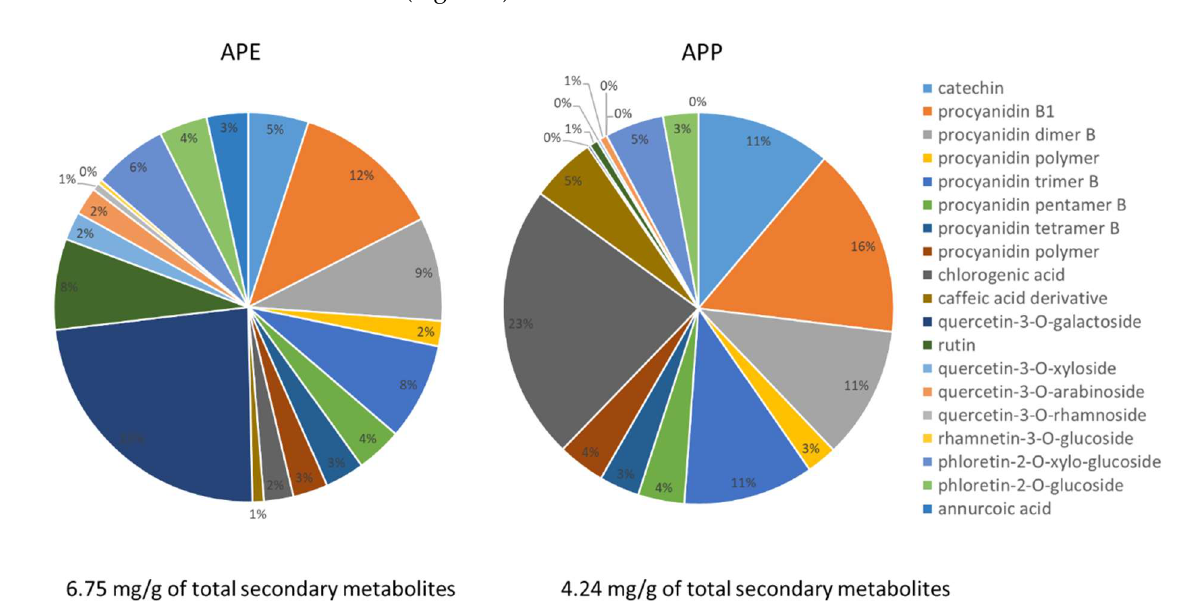
Figure 2. Graphical representation of percentage of each secondary metabolite identified in APE and APP.